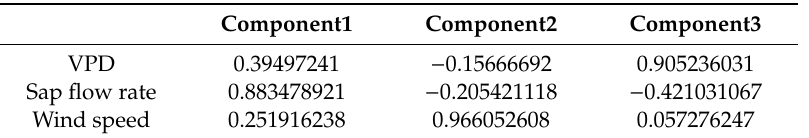
Figure 9. Recentered component configuration after applying PCA to the observations. The lengths of the vectors indicate the contribution of the specific observation. Table 2. Details of the principle components.